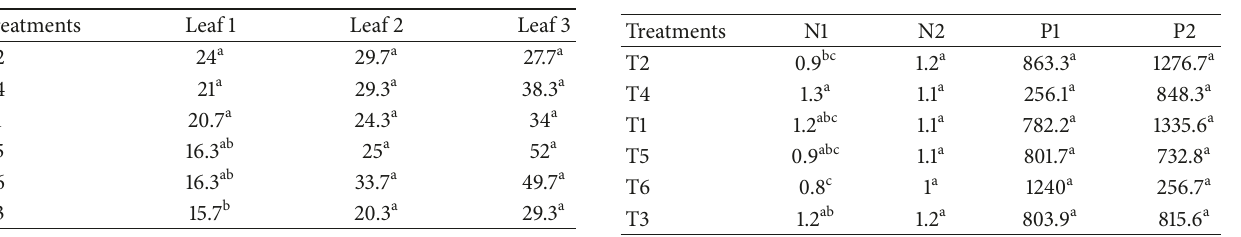
Table 6: Means of nitrogen and phosphorous